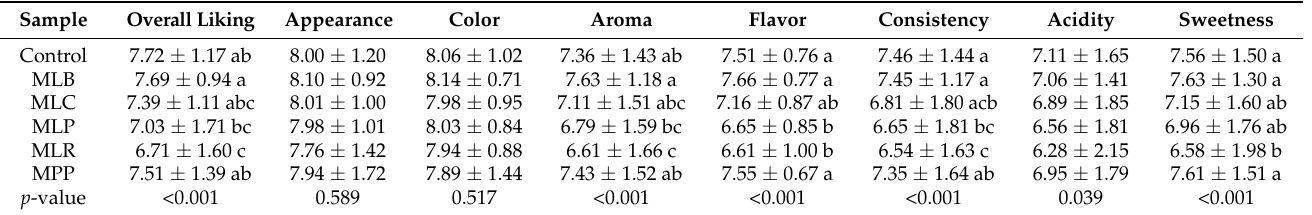
Table 3. Mean ± SD scores (9-point hedonic scale) for overall liking and sensory attributes of the control and fermented mango